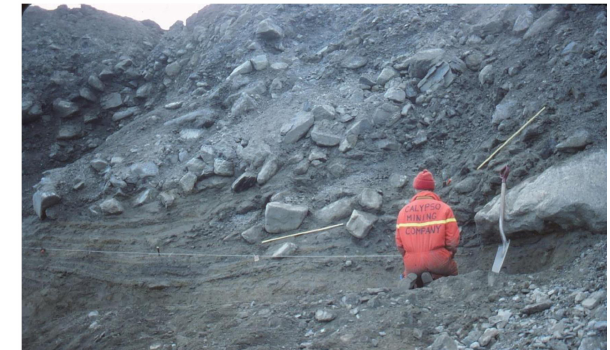
Figure 10. Preserved Mytilus edulis in the LIG sediments at Kapp Ekholm, Svalbard. This mollusc requires warmer water than the conditions around Svalbard for the last millennia, until it immi- grated in 2004. Photo Jan Mangerud, 1988.